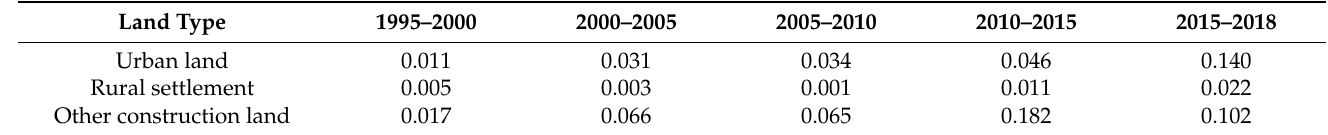
Table 6. Expansion rate of the different CL types in RBCs